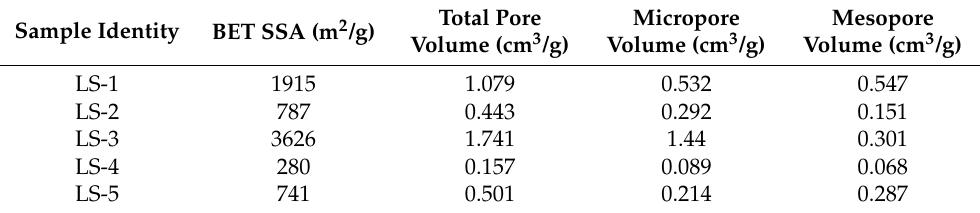
Figure 2. N 2 adsorption–desorption isotherms at 77 K ( a ); NLDFT-based pore size distribution ( b ). Table 2. Pore textual